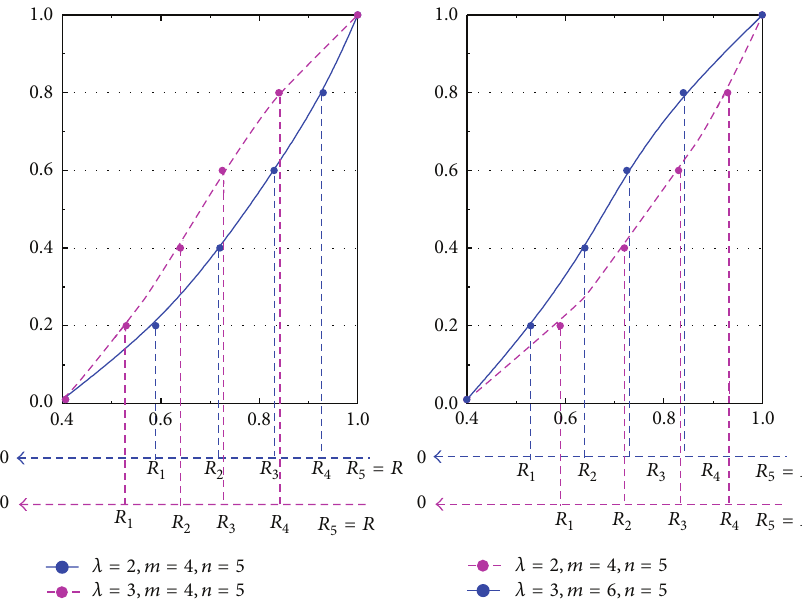
Figure 4: The relationship among the division of the hierarchical radius and the number of channels and throughput density.